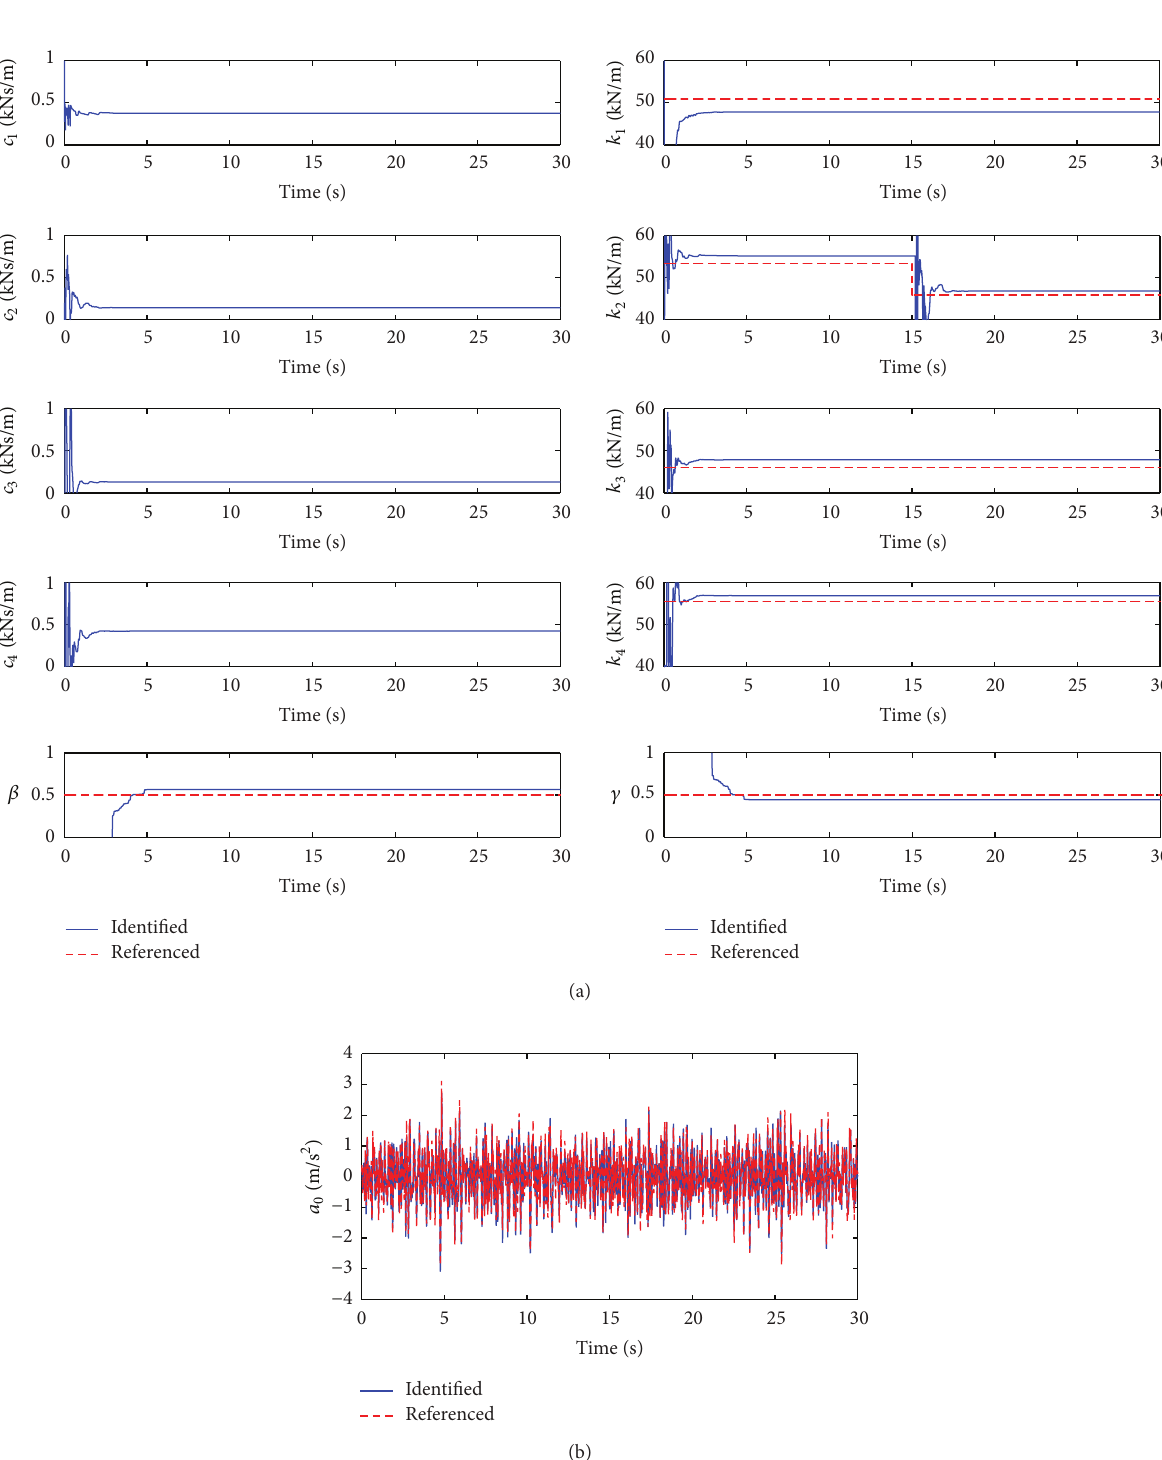
Figure 6: Identified results for Case 1: (a) identified parameters and (b) identified